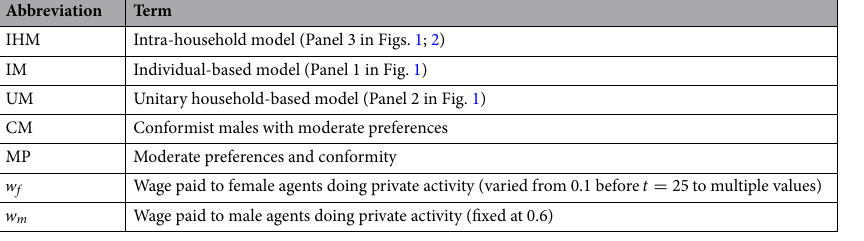
Table 1. Glossary of